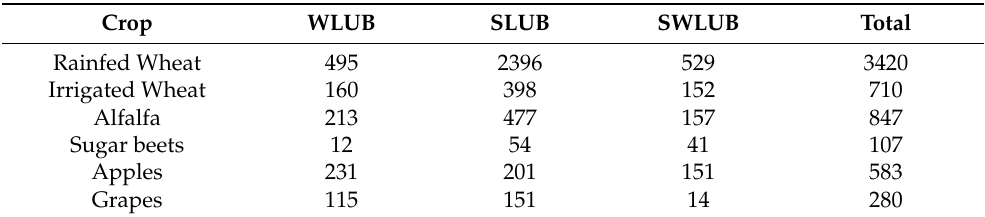
Figure 1. Study area and location of major agricultural sites in Lake Urmia Basin. Table 1. Total crop area (km 2 ) for the selected crops in west of Lake Urmia (WLUB), South of Lake Urmia (SLUB), and southwest of Lake Urmia (SWLUB).